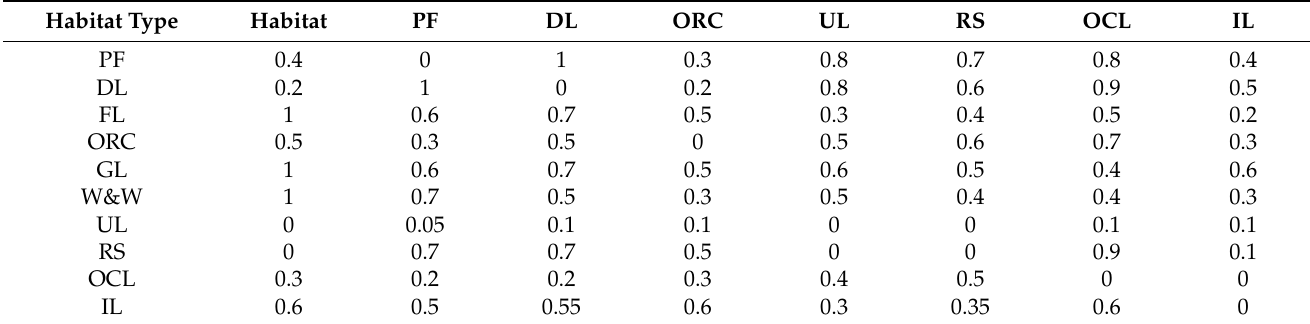
Table 2. Habitat score of each land use